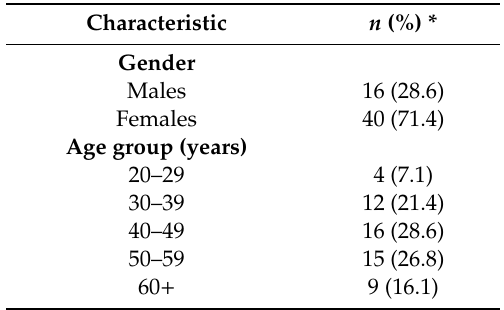
Table 3. Characteristics of the focus group discussion (FGD)